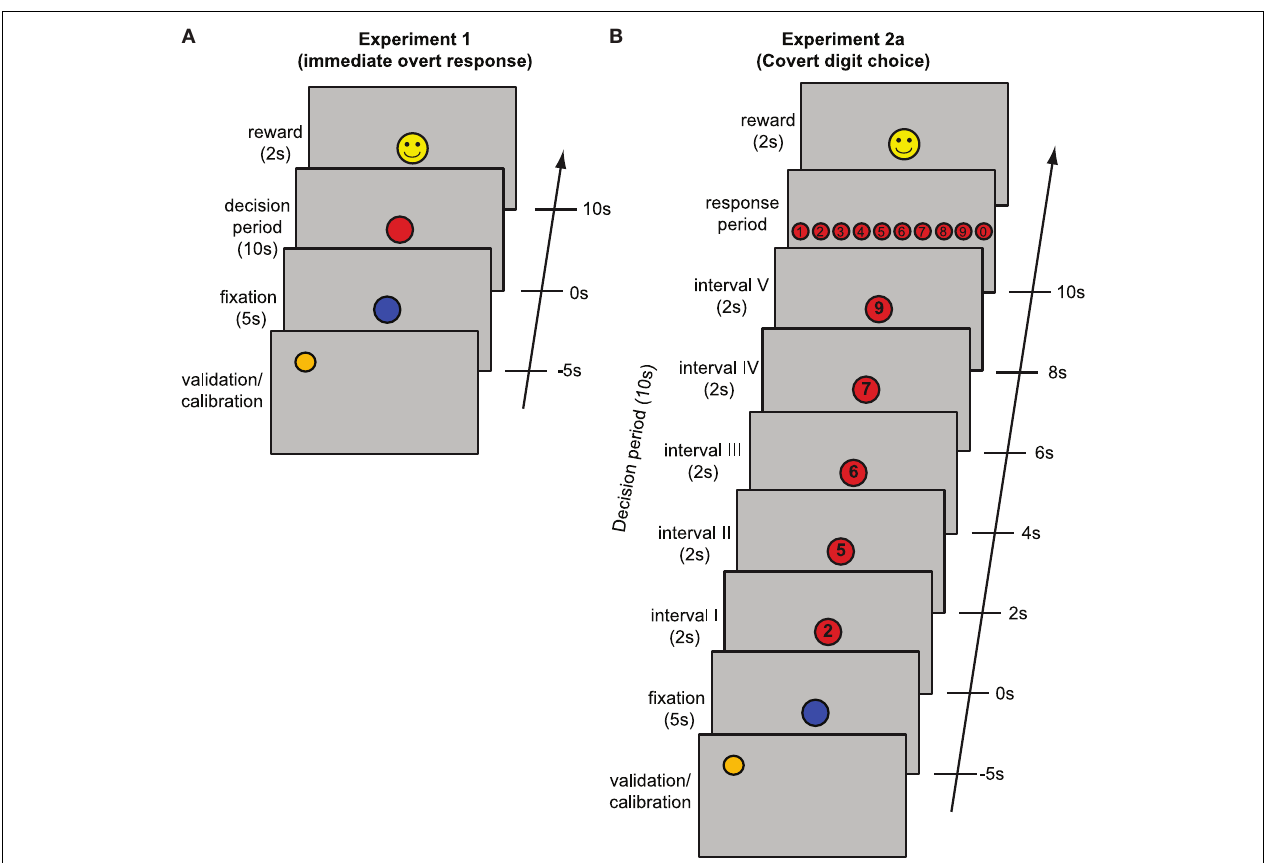
FIGURE 1 | Paradigm. Schematic of a single trial, including the preceding validation/calibration period, the fi xation period (blue circle), the actual trial (decision and response), and reward indication (details see Materials and Methods). (A) Experiment 1 (B) Experiment 2a. Time is running from bottom to top, display items are not to